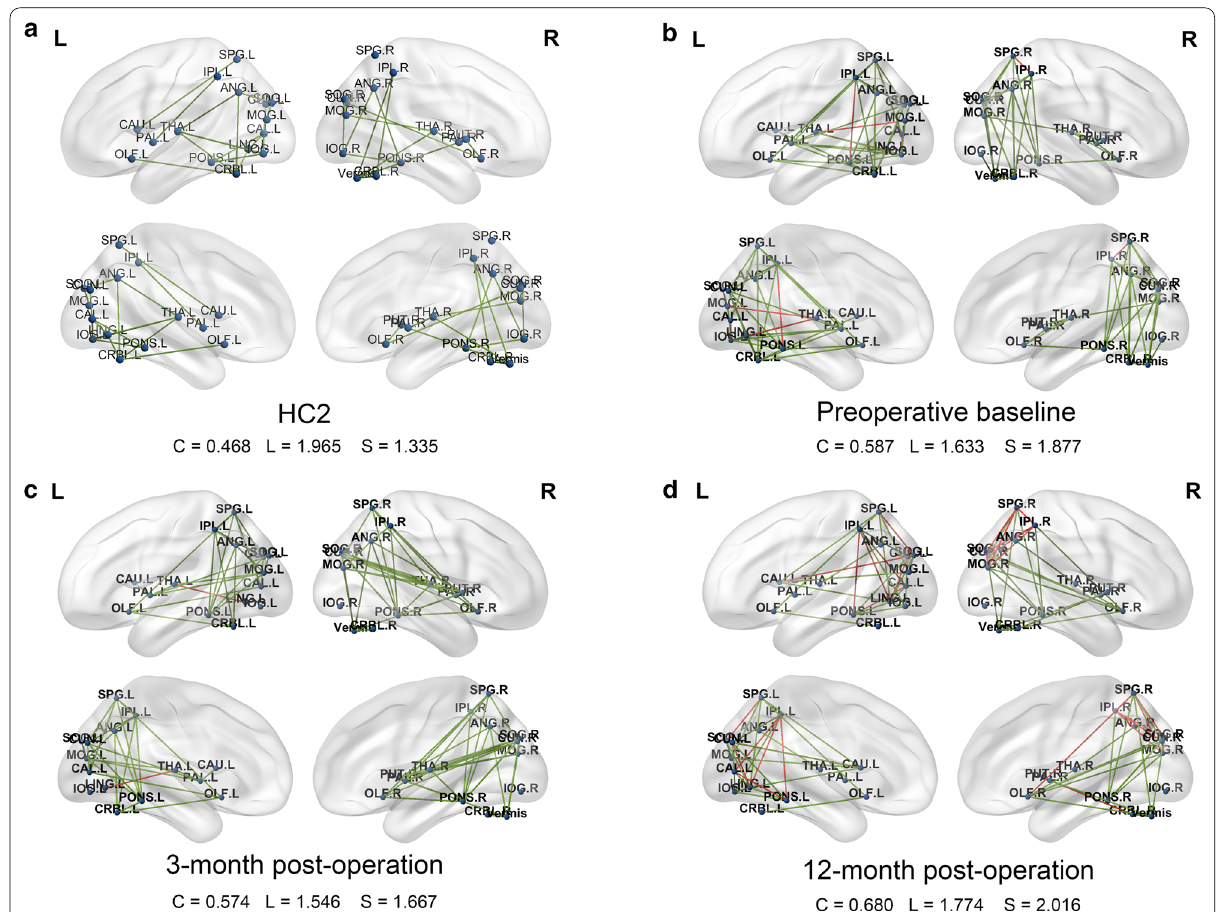
Fig. 2 The metabolic connection network of HC2 subjects ( a ), PD2 patients at baseline ( b ), PD2 patients at 3-month post-operation ( c ), PD2 patients at 12-month post-operation ( d ) in PDRP subspaces at a sparsity threshold of 25%. The blue circle nodes indicate different anatomical brain regions. Red and green lines indicate pathological (i.e., significantly altered, P -value with FDR correlated < 0.05) and normal metabolic connection between brain regions of PDRP